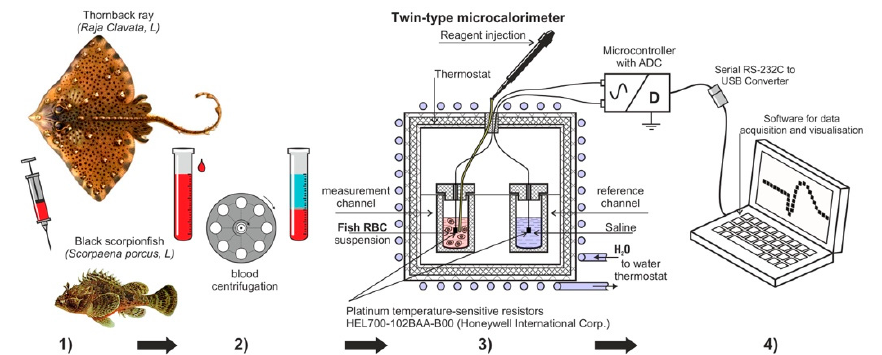
Figure 1. The experimental design used in this study (1) Getting blood from thornback ray and black scorpionfish; (2) Obtaining suspensions from fish erythrocytes washed from plasma; (3) Measurement of the dynamics of temperature change ∆ T (T1–T2) between the control experimental cells; (4) Visual observation of the experience, processing, and registration of the obtained data).